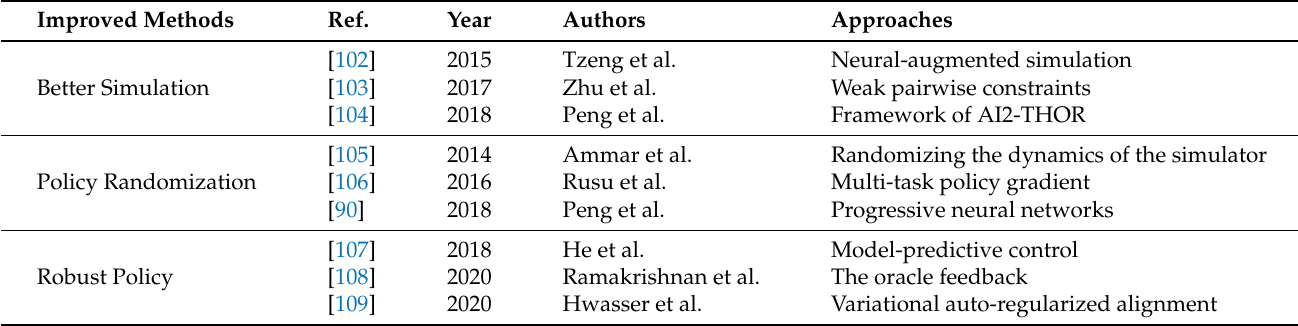
Table 3. Improved methods for robot transfer learning.